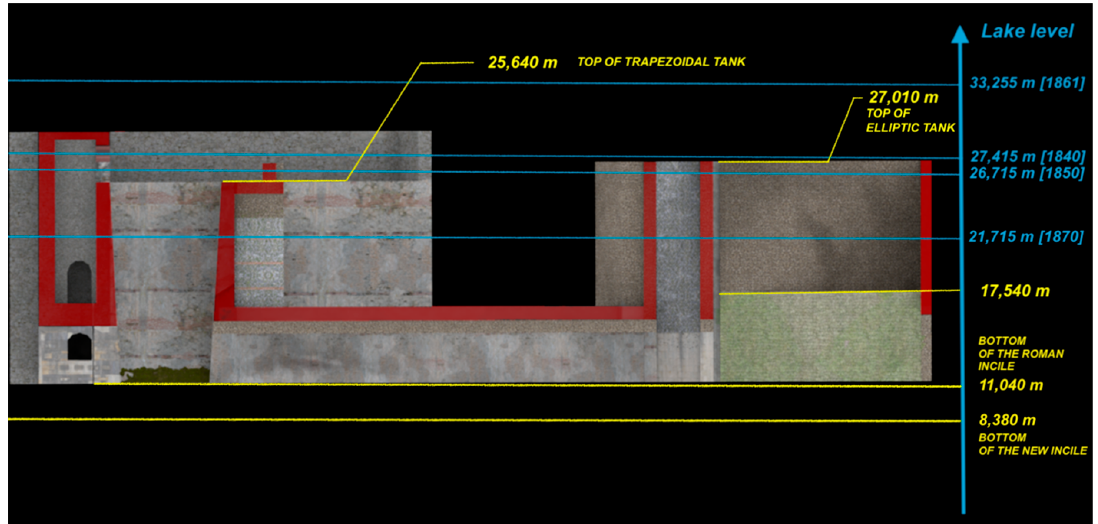
Figure 15. Longitudinal section of the Roman incile with the water levels of Fucino Lake in the 19th century.